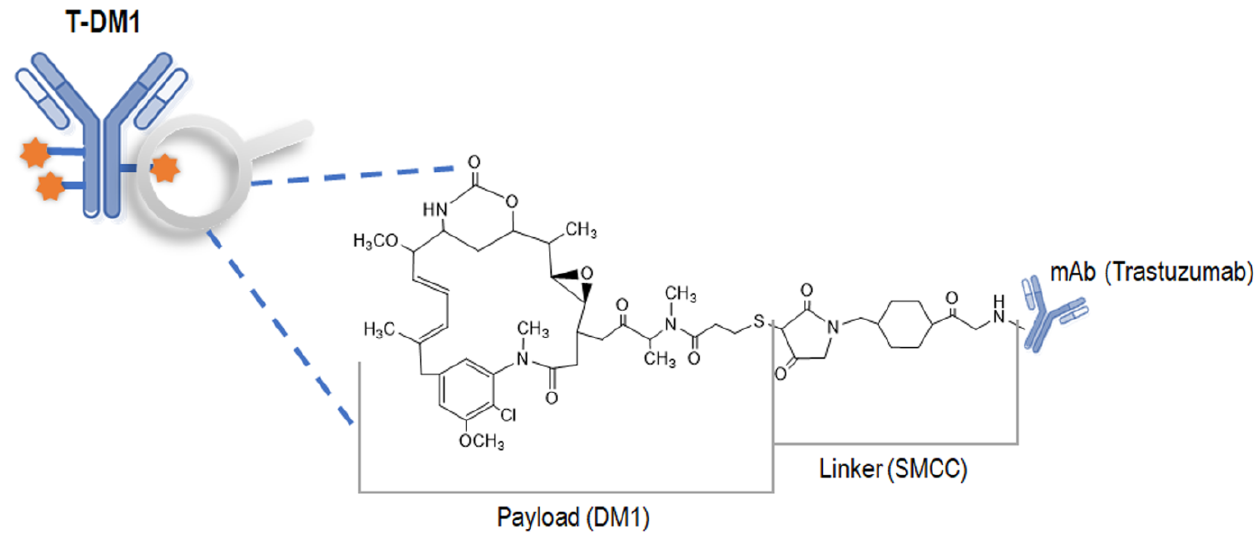
Figure 1. Chemical structure of T-DM1. T-DM1, a type of ADC, consists of the monoclonal antibody trastuzumab, a thioether linker SMCC, and the potent cytotoxic agent DM1 (also known as the pay- load). The payload linked in a part of T-DM1 is magnified.